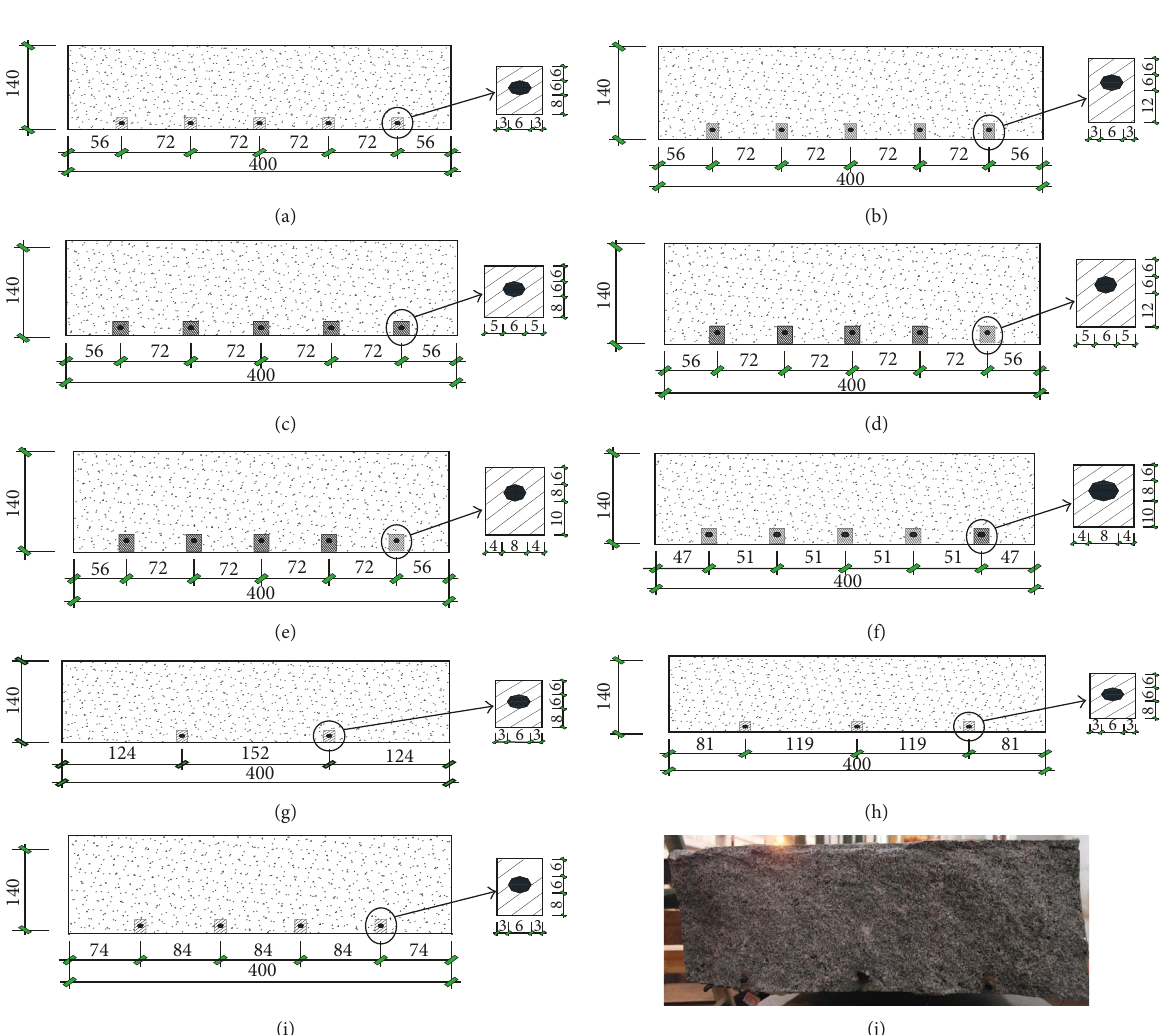
Figure 8: Dimensions of stone slab specimens: (a) GB-1; (b) GB-2; (c) GB-3; (d) GB-4; (e) GB-5; (f) GB-6; (g) CB-1; (h) CB-2; (i) CB-3; (j) section photo of CB-2.